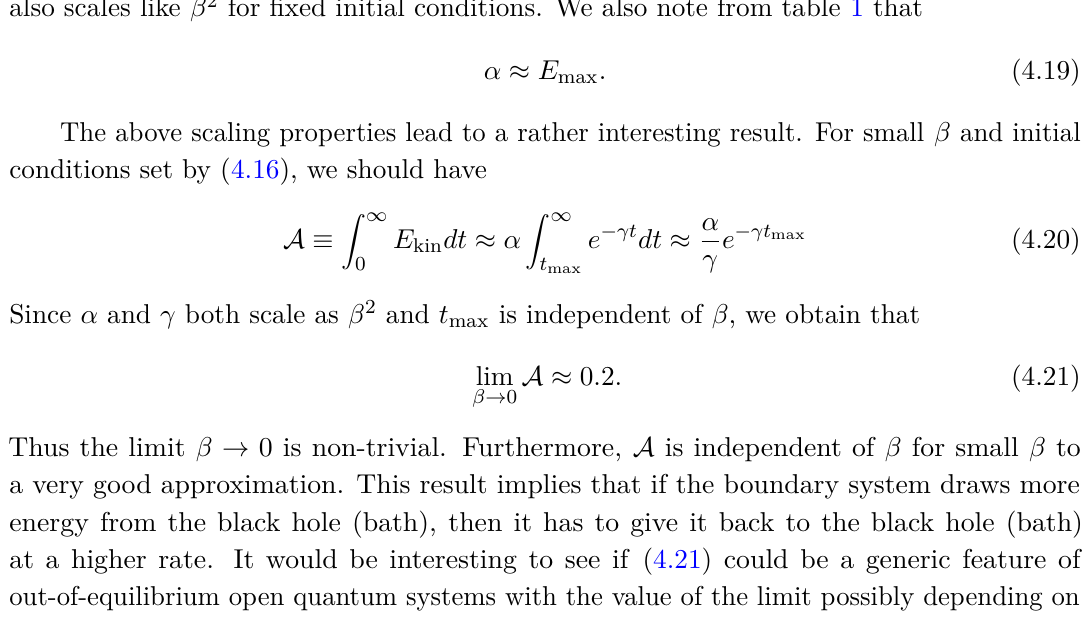
Table 1 . E kin , the kinetic energy of the boundary scalar, is fitted to function αe − γt from t = 10 to t = 18 . 5 for different values of β with the initial conditions set by (4.16). t max is the time when E kin attains its maximum value E max . The values of γ match with those predicted by (4.18) to a remarkably good accuracy. We note that t max is independent of β while α ≈ E max and both scale as β 2 . For fits see figure 13. We are using units in which the initial black hole mass is unity. also scales like β 2 for fixed initial conditions. We also note from table 1